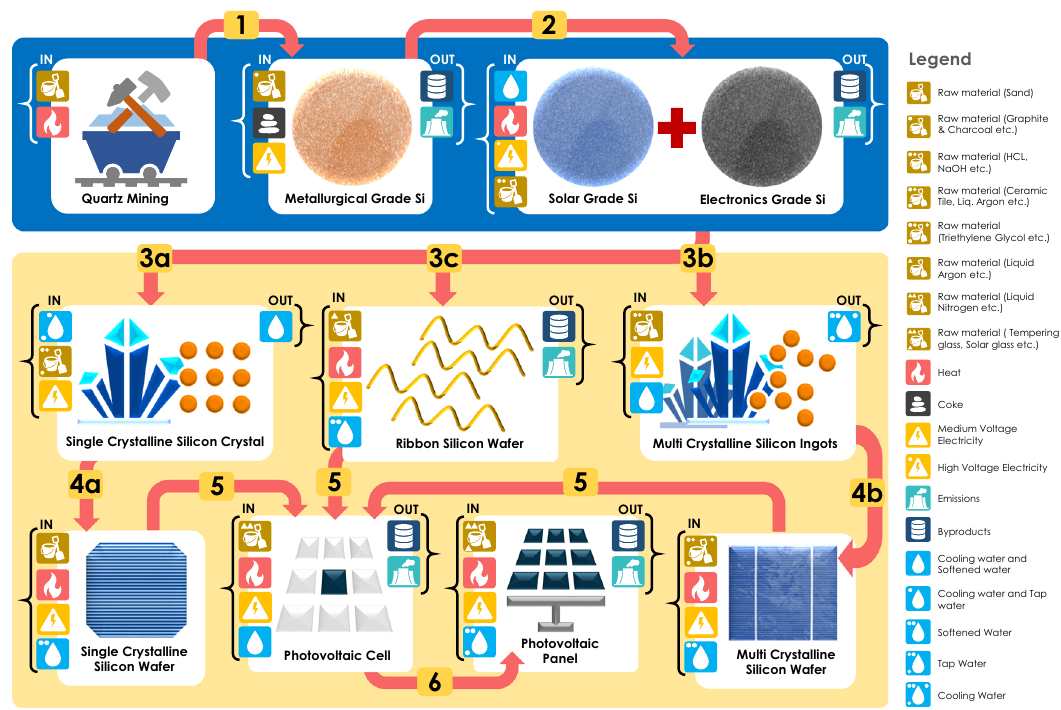
Fig.2|Crystallinesiliconphotovoltaicpanelmanufacturingstages. Theoutput from quartz mining stage is the silica sand, which is the input for the metallurgical grade silicon production (step 1). Metallurgical grade silicon is the input of both solar grade silicon production and electronics grade silicon production (step 2).